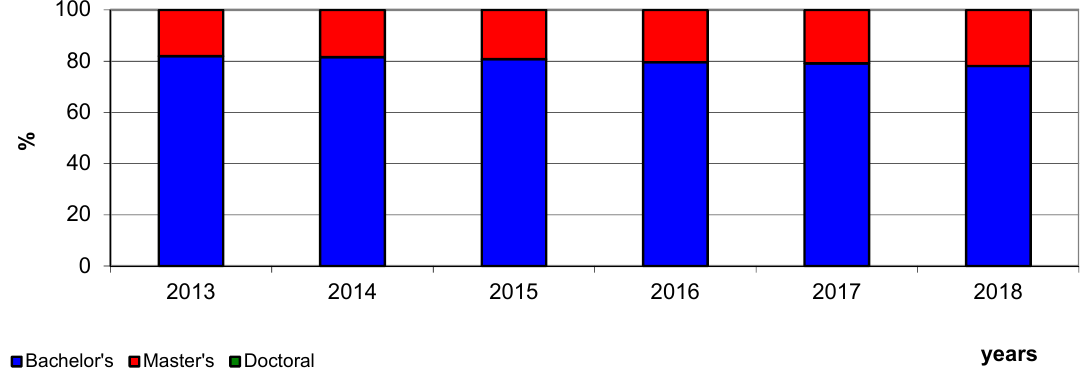
Figure 5. Structure of education in the fields of electricity and energy in the Netherlands in 2013–2018.